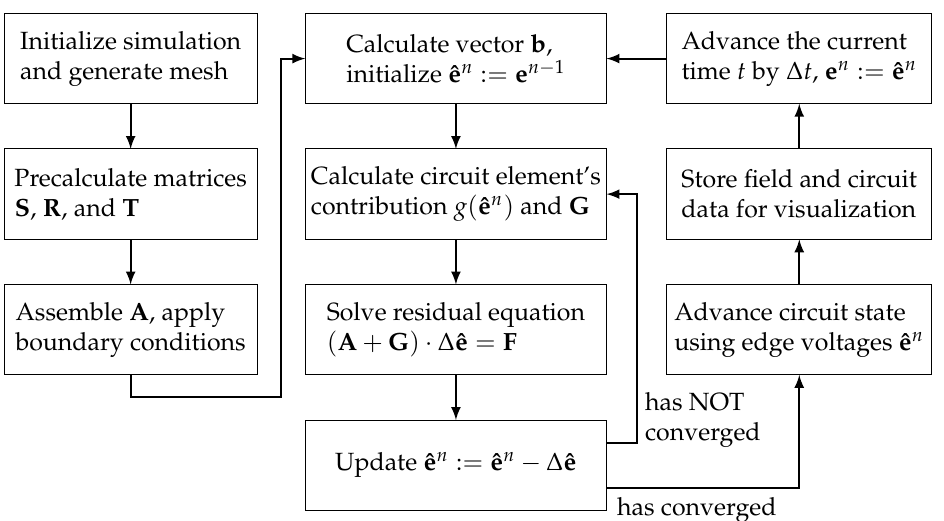
Figure 4. Diagram of the control flow in the field simulator. The inner workings of the circuit solver are left for brevity